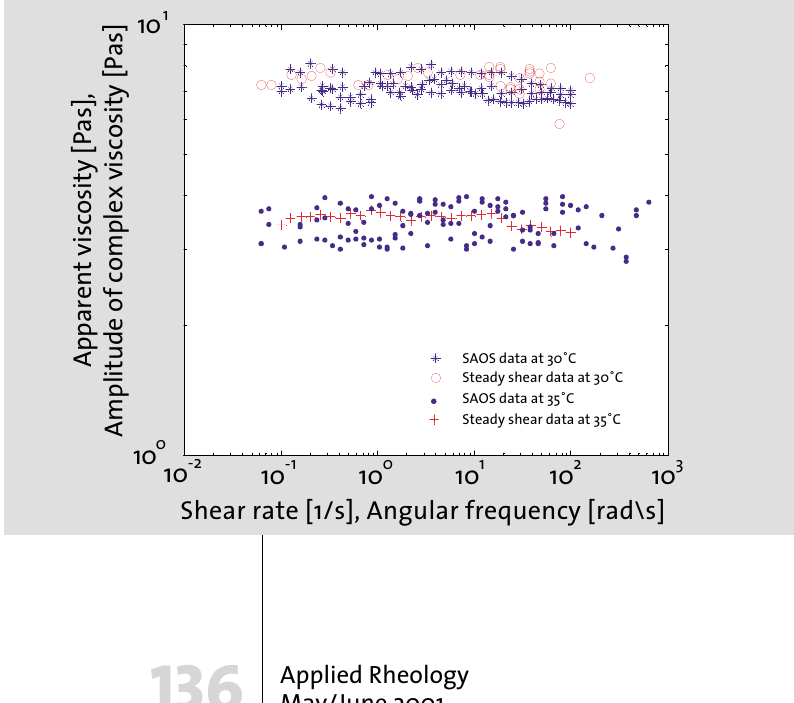
Figure 1: Steady shear flow and SAOS data for honey at 30˚C and